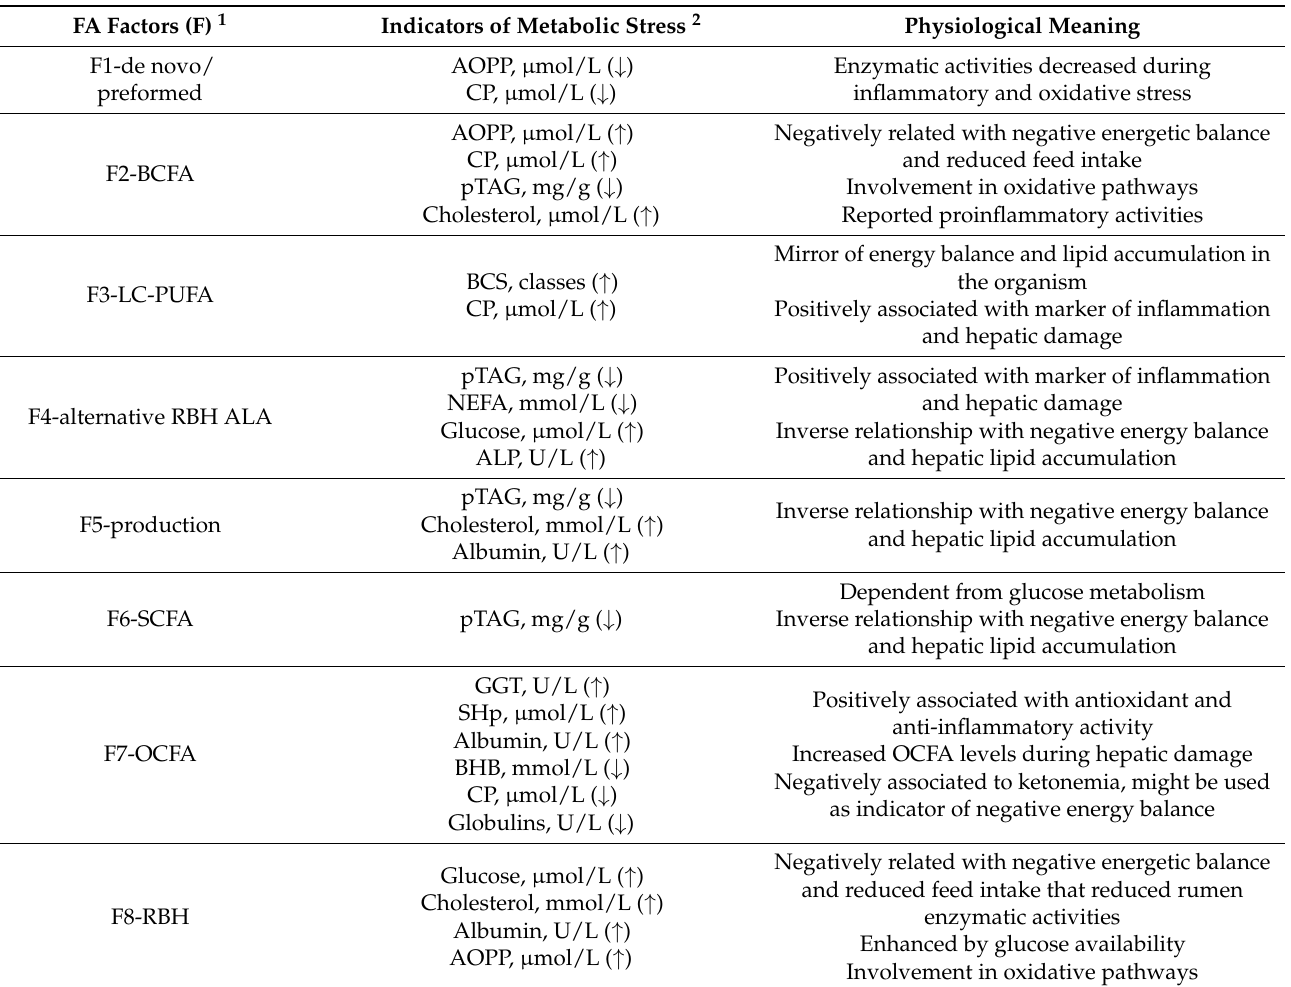
Table 5. Summary of significant associations between milk fatty acid (FA) extracted factors and indicators of metabolic stress with brief physiological meaning